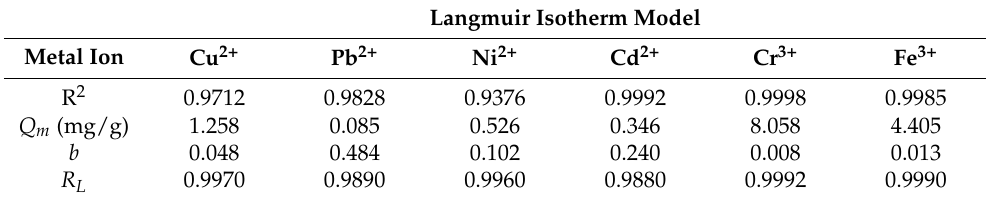
Table 5. Langmuir constants for adsorption of the M X+ onto MS.